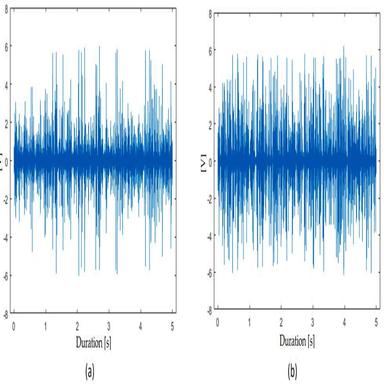
Raw AE signals from gypsum (a) and anhydrite (b) of 5 s.